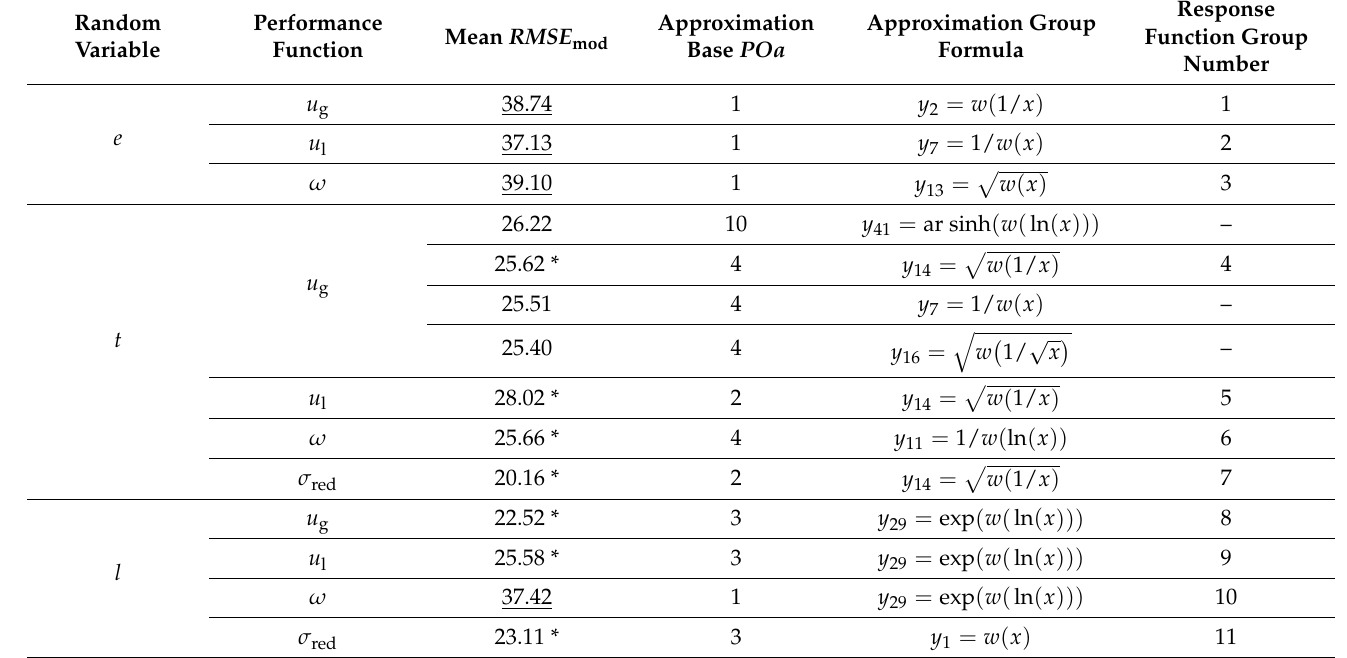
Table 7. Data on the response function selection for grillages according to the RMSE mod criterion (the final selection is underlined or